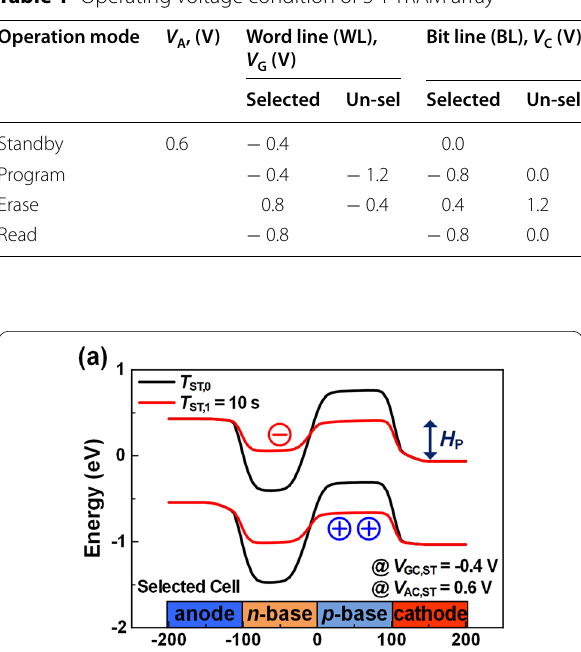
10 s (red line) and b that of the = 0 s (red =